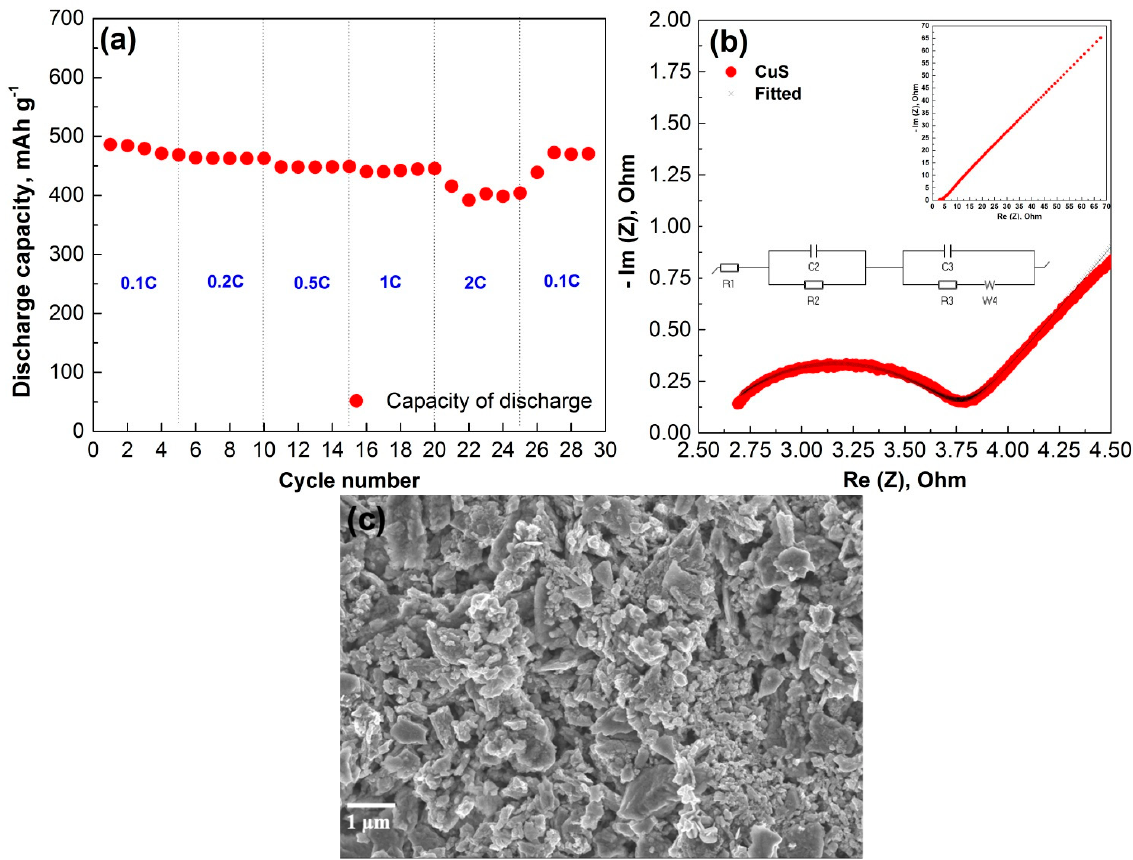
Figure 8. ( a ) Rate capability performance of CuS on Cu foam. ( b ) Nyquist plot after 5th cycle. ( c ) Post-mortem SEM image of CuS electrode after 5 cycles at 0.1 C.